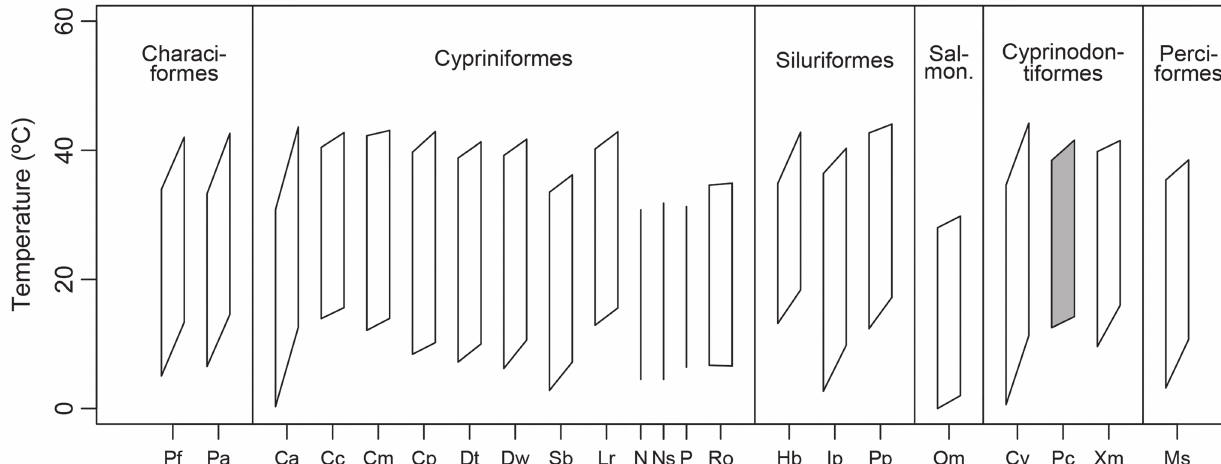
Fig. 2 . Comparison of Critical Thermal (CT) limits for Poecilia caucana (Pc, grey polygon) and a sample of species with CT and CT data available in the literature. Polygons are formed by two vertical lines representing the CT tolerance min max ranges observed at the lowest and highest acclimation temperatures used in each study. The polygons have an arbitrary width that does not reflect the range of acclimation temperatures used among different studies. The top and bottom lines of each polygon join, respectively, the CT and CT values for each species. Three species (N, Ns, and P) having data for only max min one acclimation temperature are represented by vertical lines. Pf = Prochilodus scrofa (currently Prochilodus lineatus ), fry, and Ps = P. scrofa , adults (Barrionuevo & Fernandes, 1995); Ca = Carassius auratus (Ford & Beitinger, 2005); Cc = Catla catla and Cm = Cirrhinus mrigala (Das et al ., 2004); Cp = Cyprinus carpio (Chatterjee et al ., 2004); Danio rerio , transgenic breed, and D. rerio , wild (Cortemeglia & Beitinger, 2005); Sb = Siphateles bicolor (McClanhan et al ., 1986); Lr = Labeo rohita (Chatterjee et al ., 2004; Das et al ., 2004); N = Notropis chrysocephalus , Ns = N. spilopterus , P = Pimephales notatus (Hockett & Mundahl, 1989); Ro = Rhinichthys osculus (Kaya et al ., 1992); Hb = Horabagrus_brachysoma (Dalvi et al ., 2009); Ip = Ictalurus punctatus (Currie et al ., 1998); Pp = Pangasius pangasius (Debnath et al ., 2006); Om = Oncorhynchus mykiss (Currie et al ., 1998); Cv = Cyprinodon variegatus (Bennett & Beitinger, 1997); Pc = Poecilia caucana (this study); Xm = Xiphophorus maculatus (Prodocimo & Freire, 2001); Ms = Micropterus salmoides (Currie et al. ,